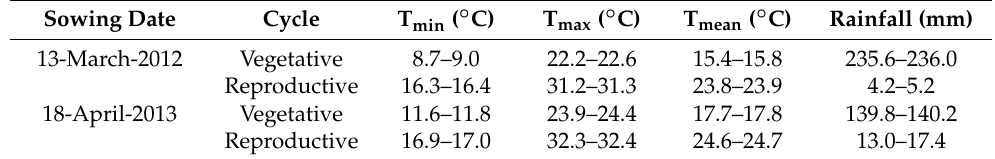
Table 3. Temperatures and rainfall during vegetative and reproductive periods of each sowing